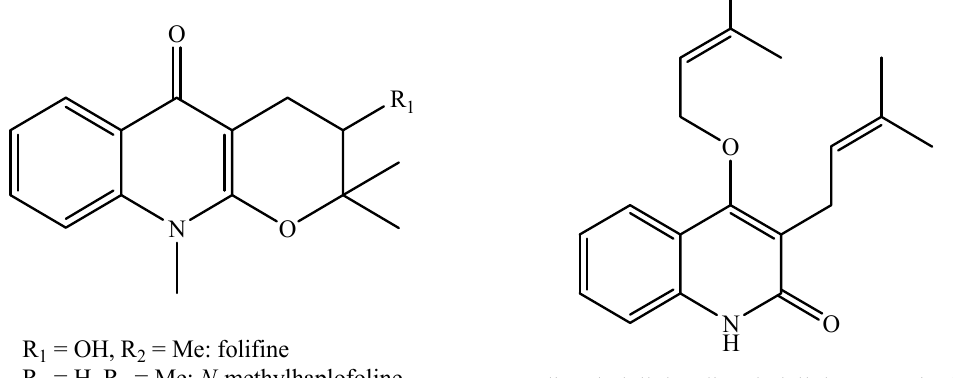
Figure 5. Structure of the alkaloids identified in Haplophyllum species—part 1.